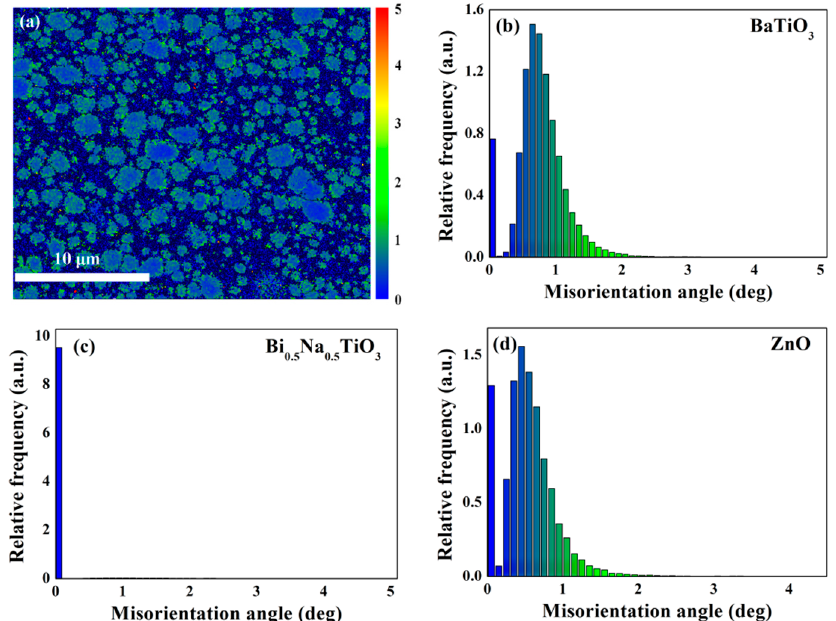
Figure 11. ( a ) Local misorientation distribution image for the selected region, and the relative fraction of sampling sites versus different misorientation angles for ( b ) BaTiO 3 , ( c ) Bi 0.5 Na 0.5 TiO 3 , and ( d ) ZnO.